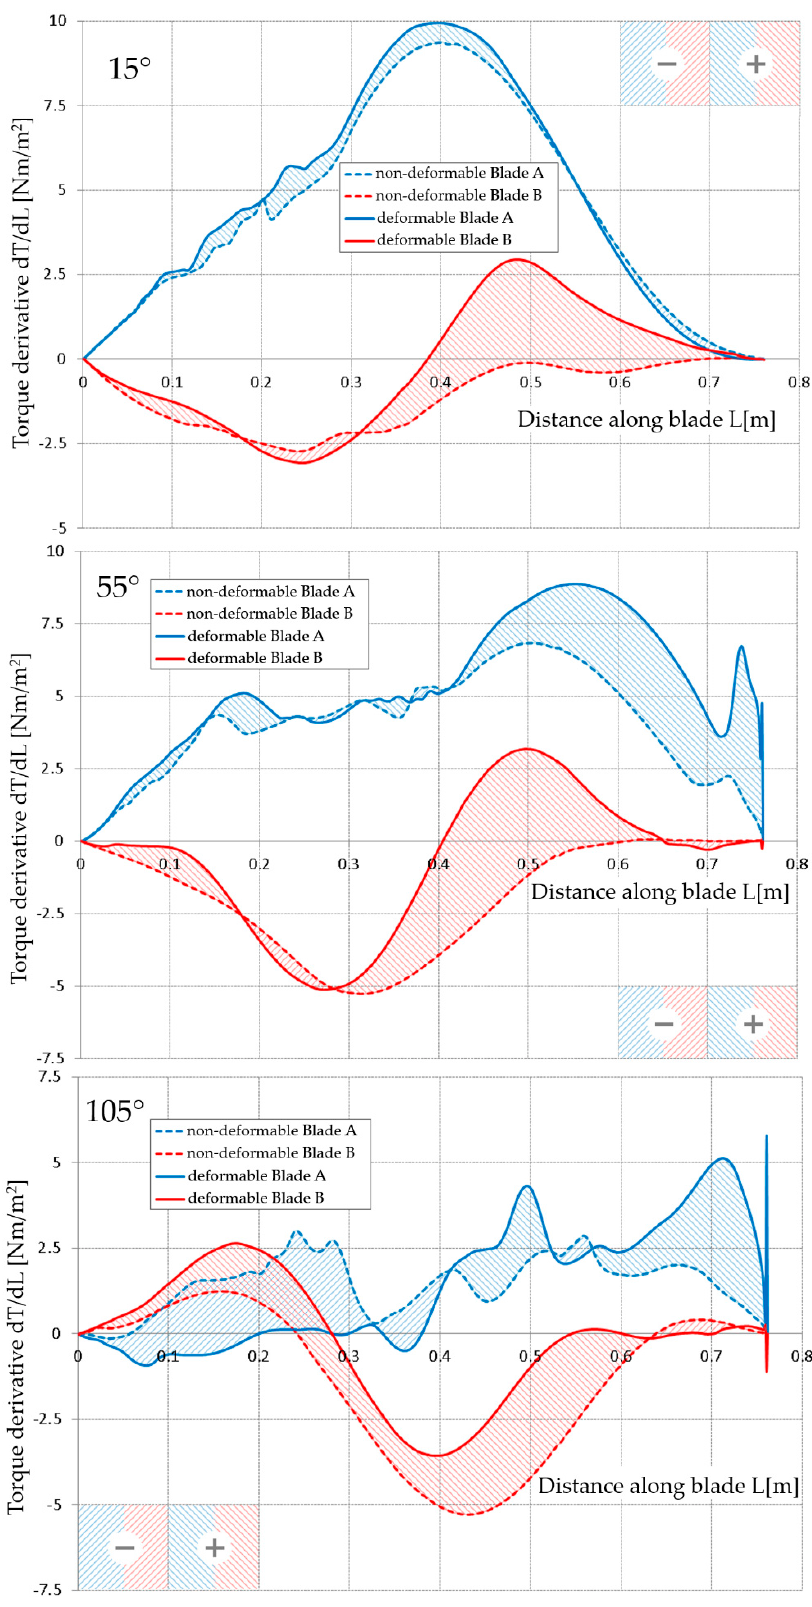
Figure 10. Torque derivative ( dT/dL ) variation along the blade for selected instants (15°, 55° and 105°) of the rotor revolution with non-deformable and deformable blades.